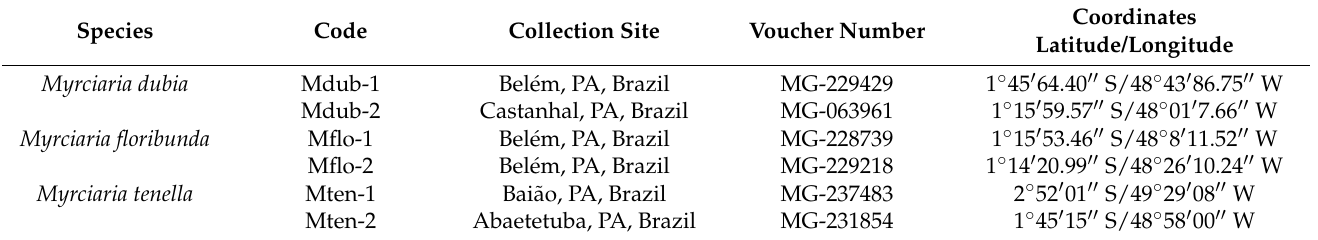
Table 2. Collection site, herbarium voucher number, and geographic coordinates for the Myrcia- ria